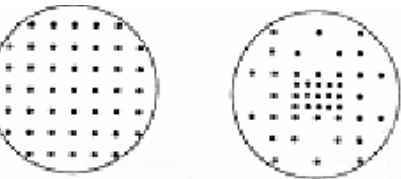
Figure 4. The relationship between centralization within the urban area and average distance between functions, symbolized with dots within circles of different